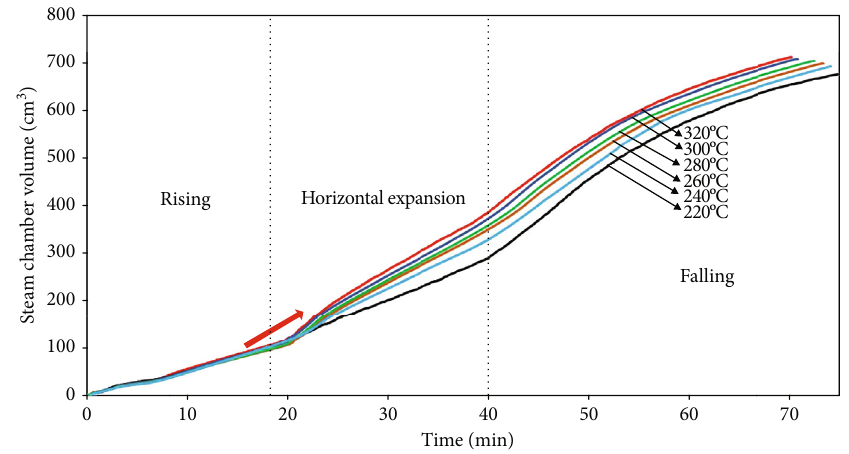
Figure 24: Steam chamber volume at di ff erent steam temperatures.